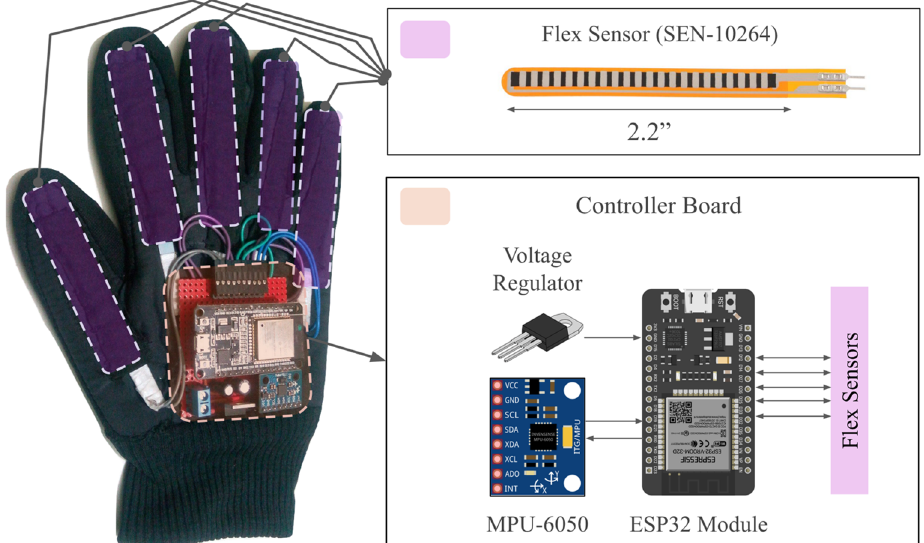
Figure 1. The dataglove architecture: On the left, we have the glove with all the mounted sensors and electronics. A flex sensor is shown in the top right corner. The components of the main controller board are shown in the bottom right corner. It consists of an ESP32 microcontroller, an MPU-6050 IMU, and some complementary